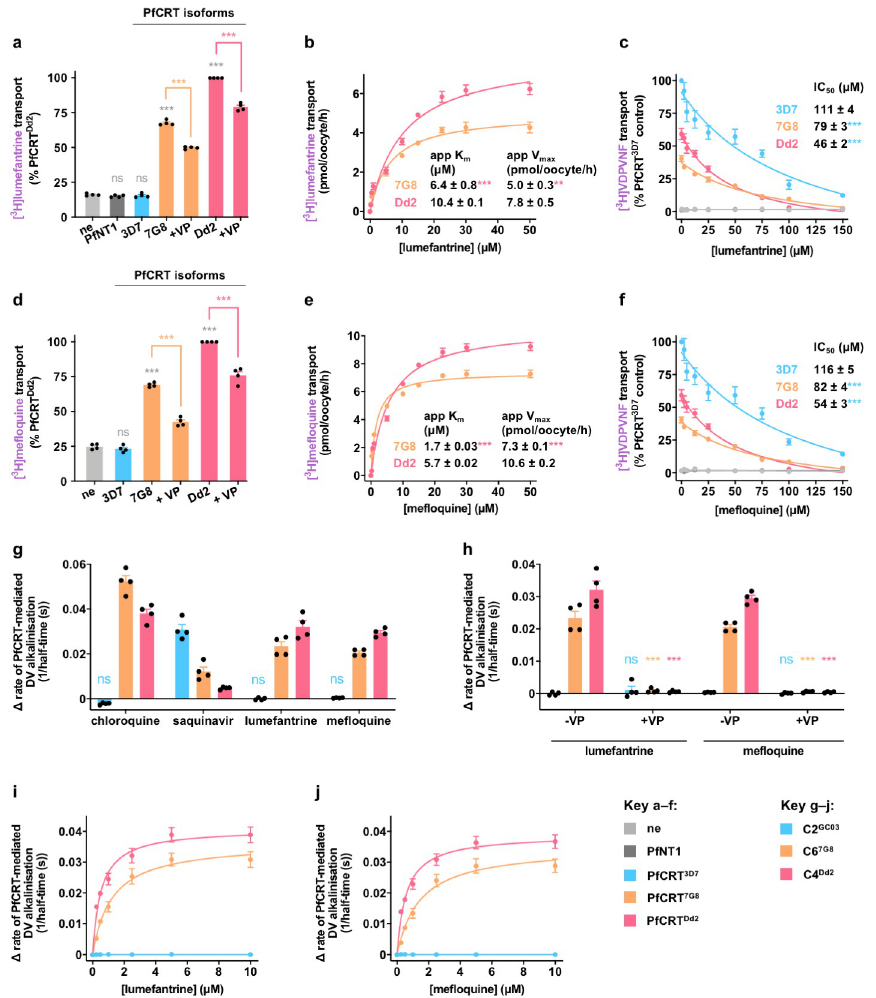
Fig 6. Transport of lumefantrine and mefloquine via PfCRT in Xenopus oocytes and in situ. (a, d) The transport of [ 3 H]lumefantrine (a) and [ 3 H]mefloquine (d) via PfCRT Dd2 and PfCRT 7G8 was reduced by verapamil (VP; 100 μ M). The asterisks denote a significant difference from the ne (gray asterisks), the PfCRT 7G8 control (orange asterisks), or the PfCRT Dd2 control (red asterisks). (b, e) The transport of lumefantrine (b) and mefloquine (e) via PfCRT Dd2 and PfCRT 7G8 was saturable. The asterisks denote a significant difference from PfCRT Dd2 (red asterisks). (c, f) The effects of unlabeled lumefantrine (c) and unlabeled mefloquine (f) on [ 3 H]VDPVNF transport via PfCRT 3D7 , PfCRT Dd2 , and PfCRT 7G8 . The asterisks denote a significant difference from PfCRT 3D7 (blue asterisks). (g) Lumefantrine and mefloquine (2.5 μ M) increased the rate of DV alkalinization in the chloroquine-resistant C6 7G8 and C4 Dd2 parasite lines but not in the chloroquine-sensitive C2 GC03 line. Unless labeled ns, P < 0.05 relative to the absence of a test solute. (h) The increase in the rate of DV alkalinization caused by lumefantrine and mefloquine was inhibited by VP (50 μ M). The asterisks denote a significant difference from the relevant C2 GC03 (blue asterisks), C6 7G8 (orange asterisks), or C4 Dd2 (red asterisks) treatments in the absence of verapamil. (i, j) Lumefantrine (i) and mefloquine (j) increased the rate of DV alkalinization in a concentration-dependent manner. The data are the mean of n = 4 independent experiments, each yielding similar results and overlaid as individual data points in panels a , d , g , and h , and the error is the SEM. Where not visible, the error bars fall within the symbols. �� P < 0.01, ��� P < 0.001, ns, not significant (1-way ANOVA). The data underlying this figure is supplied in S3 Data. ne, nonexpressing oocytes; PfCRT, Plasmodium falciparum chloroquine resistance